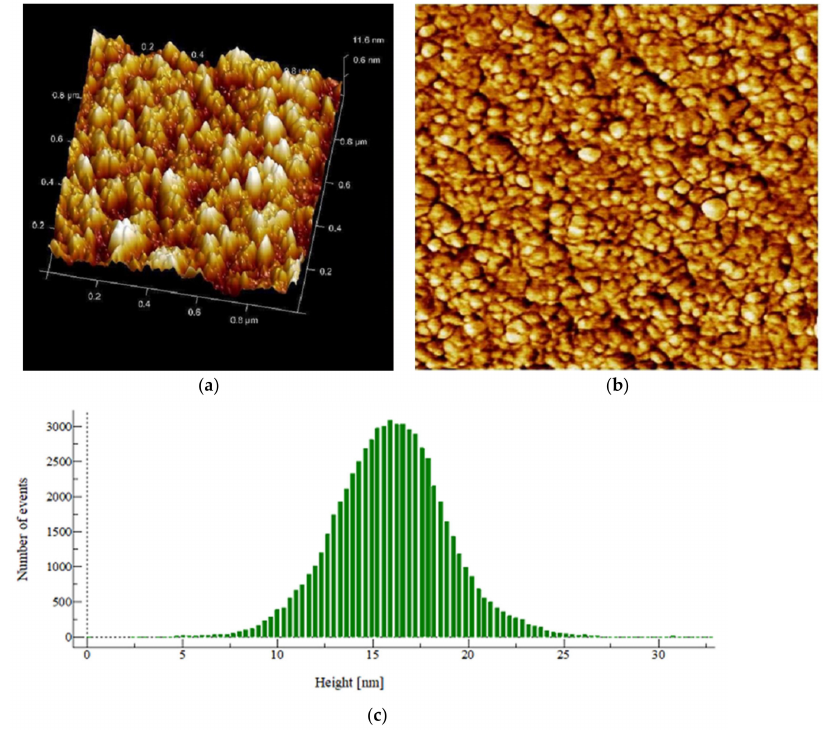
Figure 8. AFM image of S. aureus biofilm surface (treated with PHELA ® extract) formed on the polycarbonate membrane filter taken at the 1 × 1 µ m scan area in the tapping mode. ( a ) Height topography in three dimensions, ( b ) The structure and complete surface coverage of the biofilm, and ( c ) Height distribution